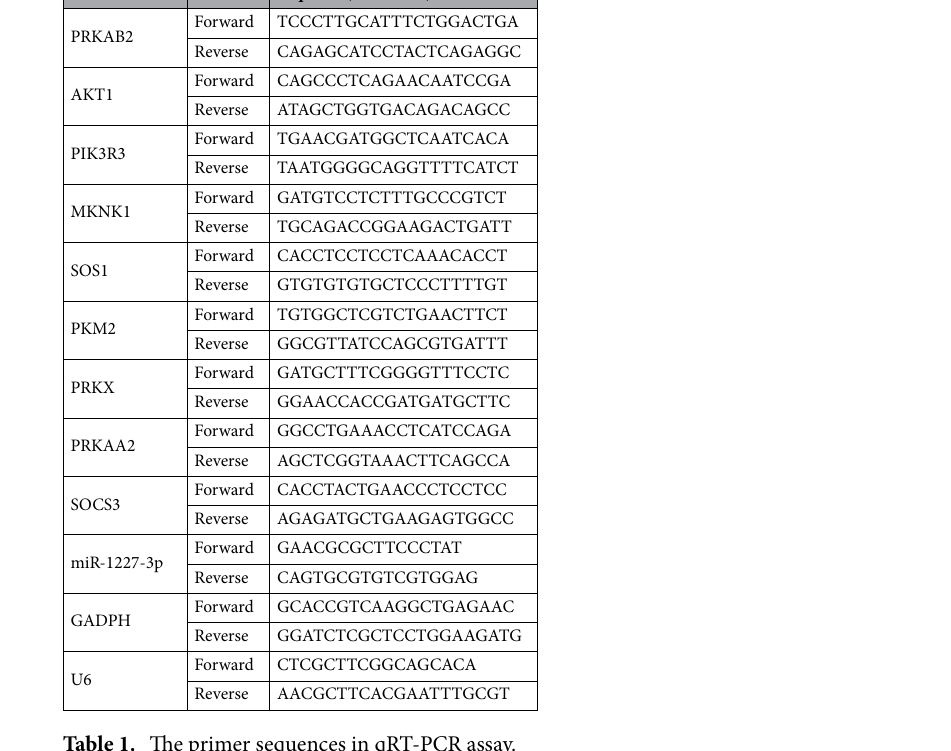
Table 1. The primer sequences in qRT-PCR